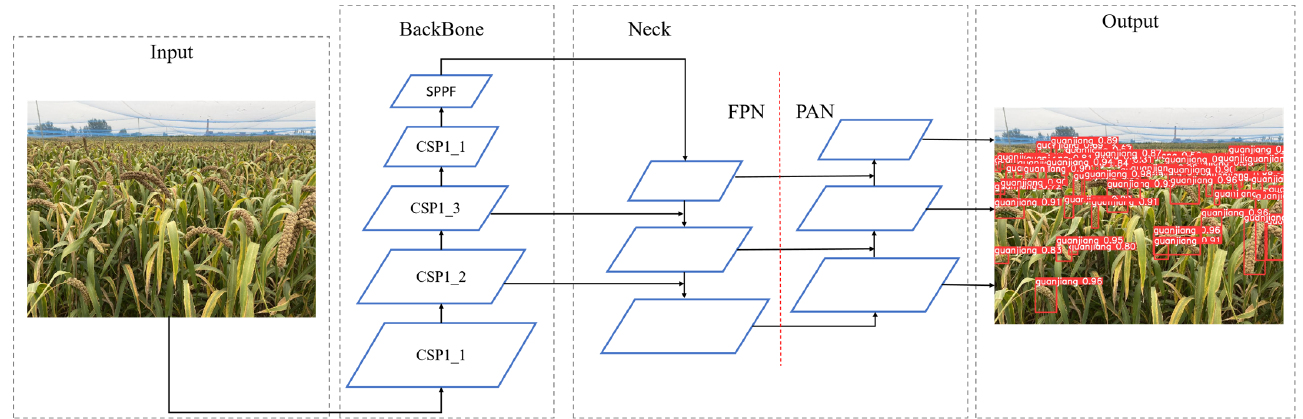
Figure 3. Structure of YOLOv5s.